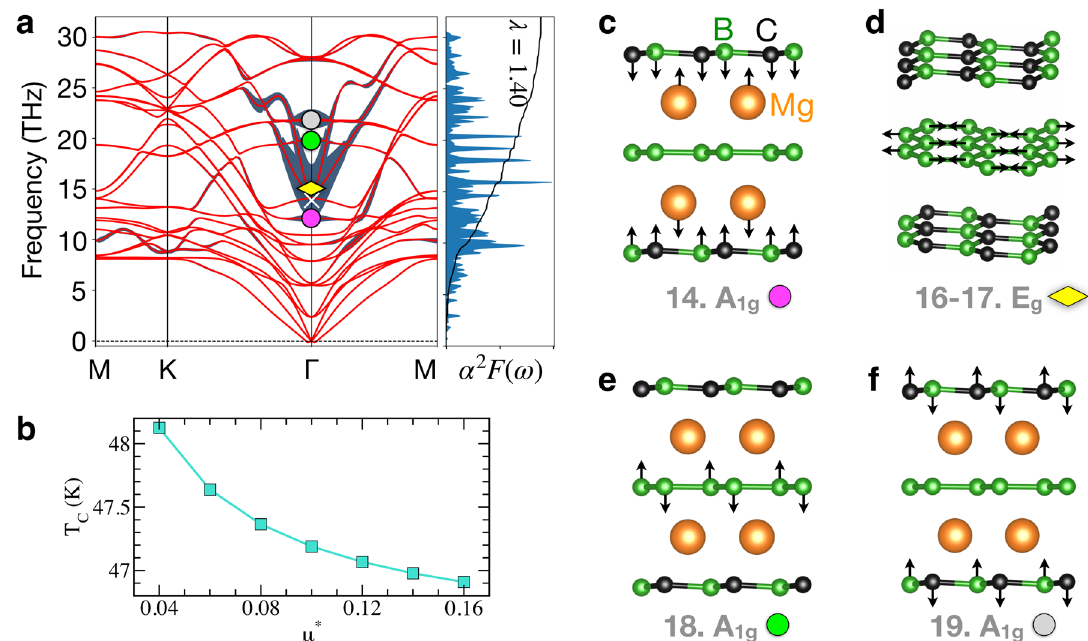
Fig. 3 Electron-phonon coupling. a Calculated phonon spectrum of Mg 2 B 4 C 2 monolayer with phonon linewidths λ ( q , n ) plotted using shaded blue color. To avoid large overlap of λ ( q , n ) with the phonon spectra, we have divided the intensity by a factor of two. The colored circles mark the three out-of-plane nondegenerate A 1 g modes (indices 14, 18, and 19), and the yellow diamond marks one in-plane doubly degenerate E g mode at Γ . These modes exhibit dominant el-ph coupling. The atomic displacement patterns corresponding to these modes are shown in ( c – f ). The nondegenerate A 1 u mode (index 15) marked using symbol ` × ' does not contribute to the total el-ph coupling, although it appears to be buried in the large λ ( q , n ) of the E g mode. The numerals 14, 15, 16, 17, 18, and 19 denote the phonon mode index as counted from the lowest to the highest frequency modes (i.e.,1-3 for acoustic modes). Mg atoms are omitted in ( c ) for the sake of clarity. The Eliashberg spectral function α 2 F ( ω ) along with the el-ph coupling constant λ in plotted in the right panel of ( a ). b Estimated T c as a function of the μ *